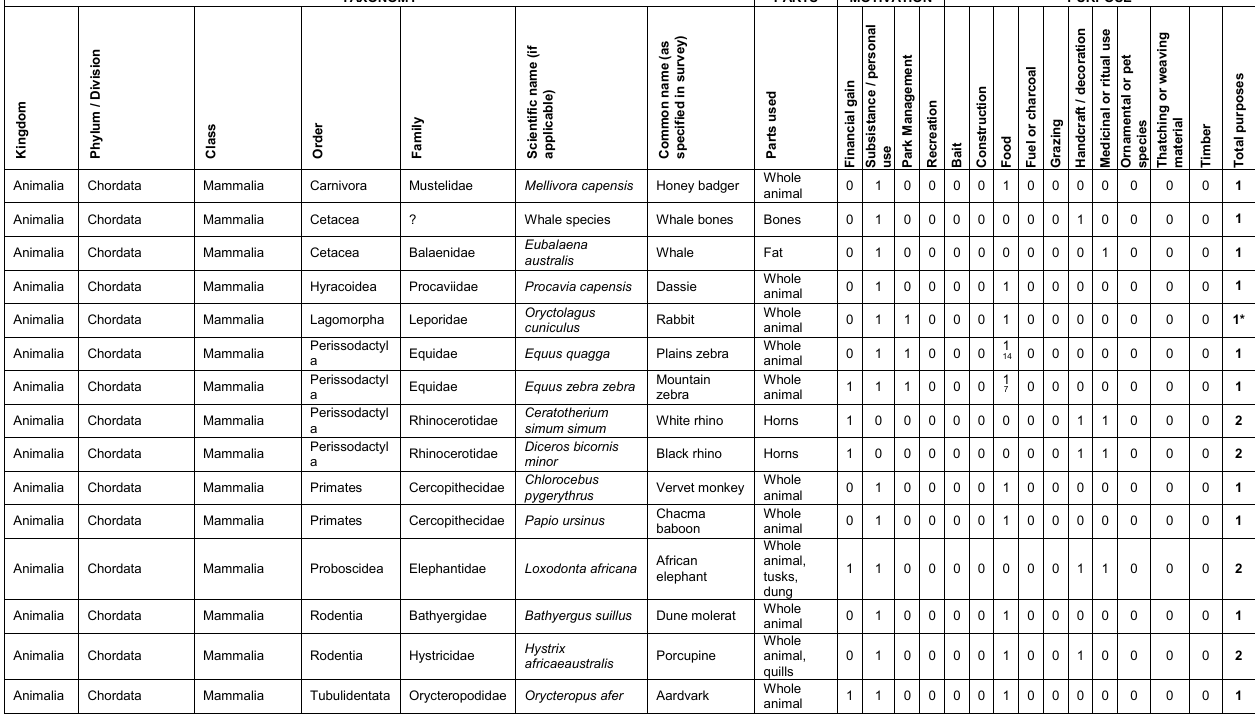
Animalia Chordata Sauropsida (reptilia) Testudines Testudinidae Chersina angulata Angulate tortoise Animalia Chordata Sauropsida (reptilia) Testudines Testudinidae Homopus signatus signatus Speckled padlper